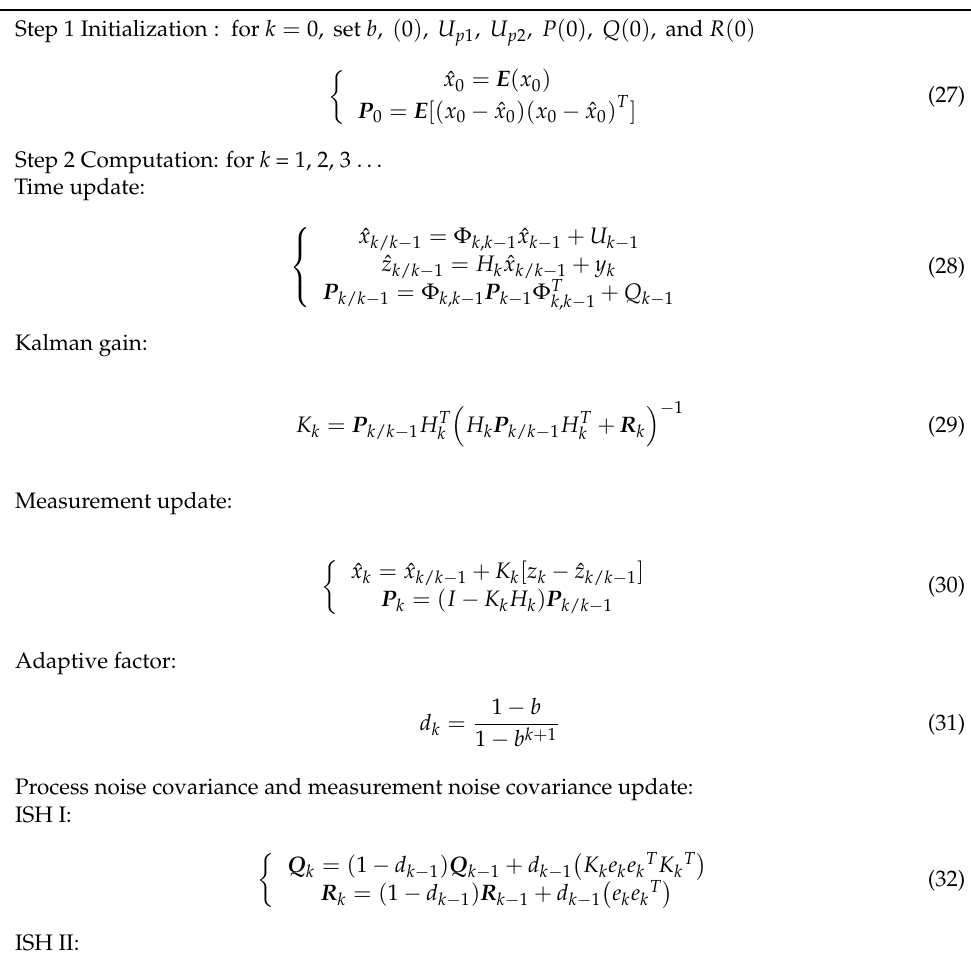
Table 1. Summary of AEKF algorithm based on the improved